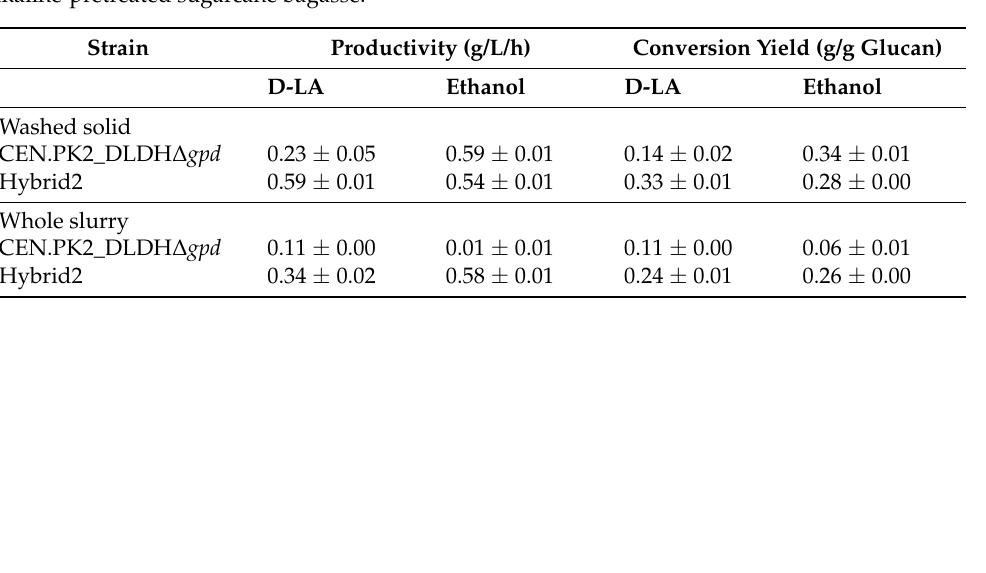
Table 3. D-lactic acid (D-LA) productivity and yield in SSF of washed solid and whole slurry of alkaline-pretreated sugarcane